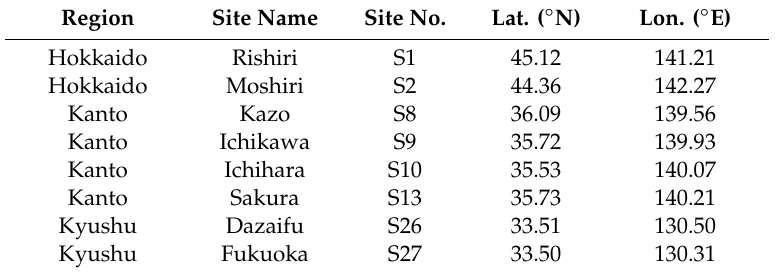
Table 1. Japan Environmental Laboratories Association (JELA) filter pack (FP) NH 3